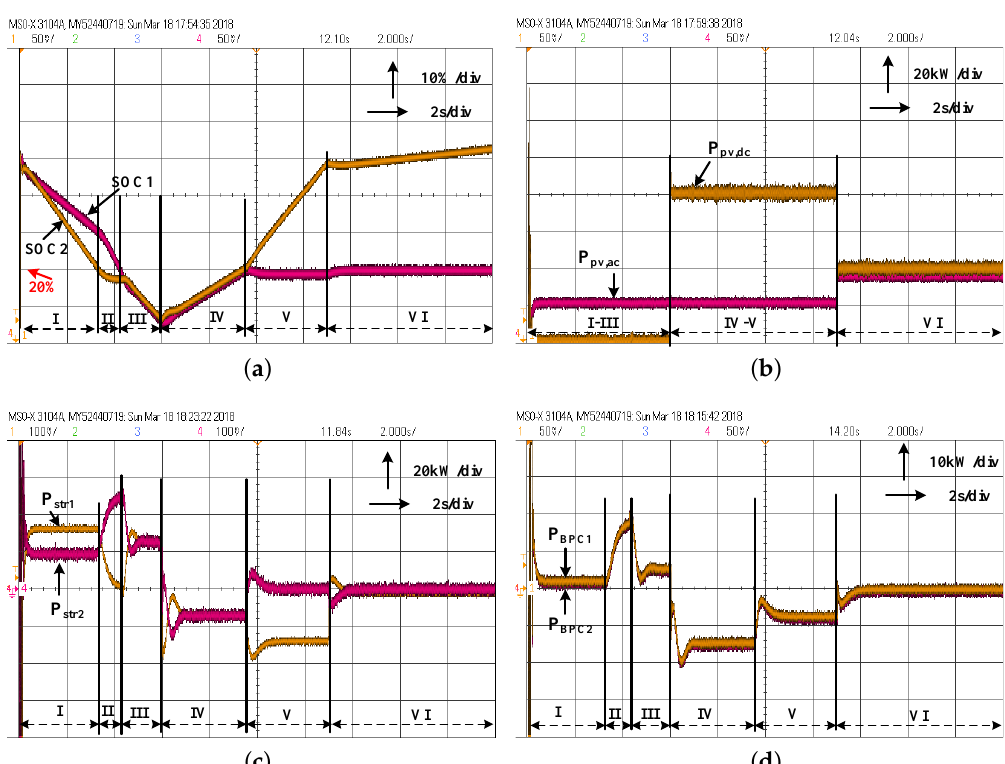
Figure 15. Test results of Case 3: ( a ) SOCs of the storage on AC side and DC side; ( b ) output power of PV; ( c ) output power of AC storage and DC storage; and ( d ) output power of